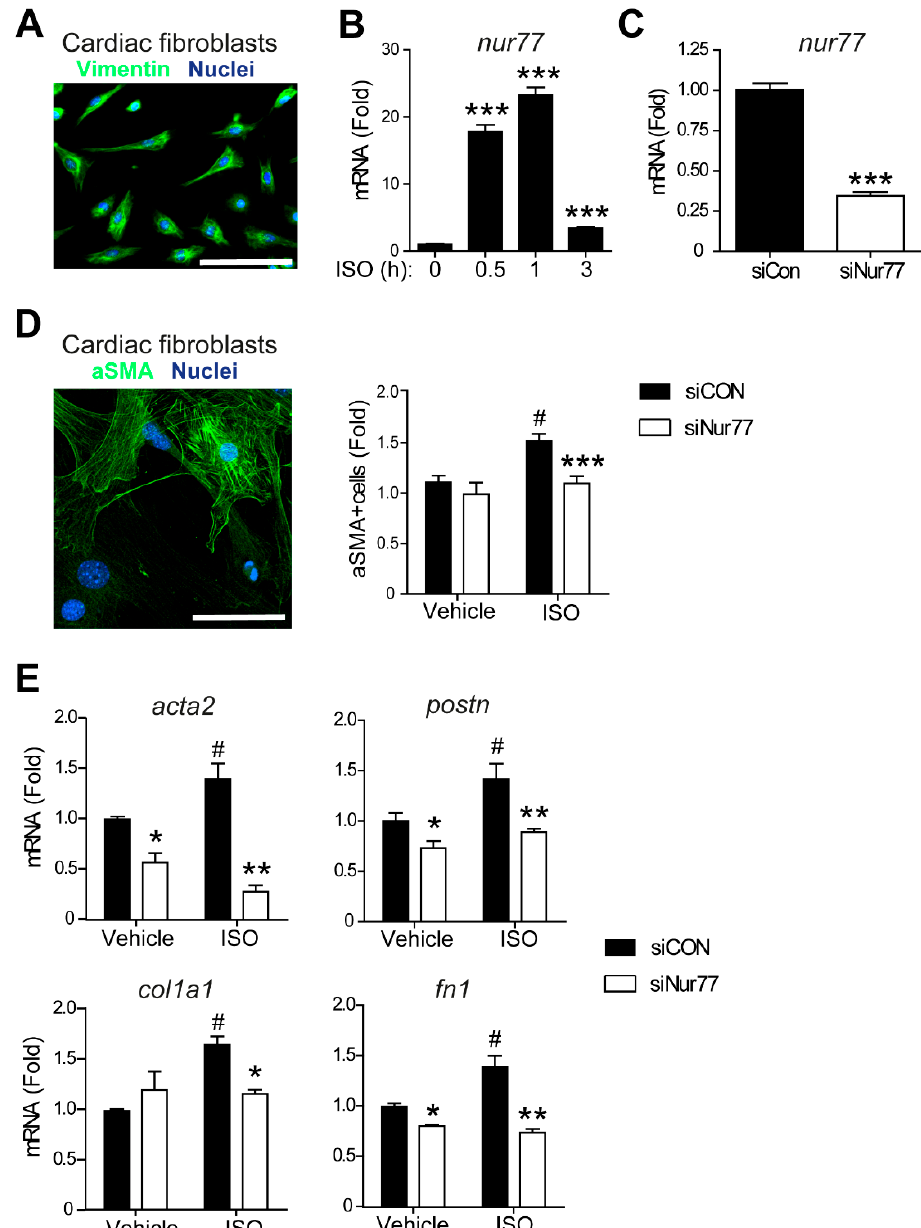
Figure 2. Nur77 knockdown in CFs promotes a MyoFB phenotype. ( A ) Primary neonatal rat CF in culture were identified by expression of fibroblast marker vimentin. Scale bar represents 100 μ m. ( B ) Induction of Nur77 mRNA expression in CFs after ISO (10 μ M) treatment. ( C ) Decreased Nur77 mRNA expression after siRNA-mediated knockdown in CFs (siNur77) compared to CFs treated with control siRNA (siCon), as measured by qPCR. ( D ) Number of CF expressing MyoFB marker α -smooth muscle actin (aSMA) as assessed by immunofluorescence. Scale bar represents 20 µ m. ( E ) MyoFB and ECM-related gene expression measured by qPCR. acta2 : α -smooth muscle actin, col1a1 : collagen type 1, fn1 : fibronectin, postn : periostin. ( D , E ) ISO stimulation (10 μ M) was for 24 h. n = 3–4 independent experiments. Data presented as mean + SEM; ( B ): *** p < 0.001 vs. t = 0; ( C – E ): # p < 0.05 vs. siCon vehicle; * p < 0.05, ** p < 0.01, *** p < 0.001 vs. siCon same stimulus.